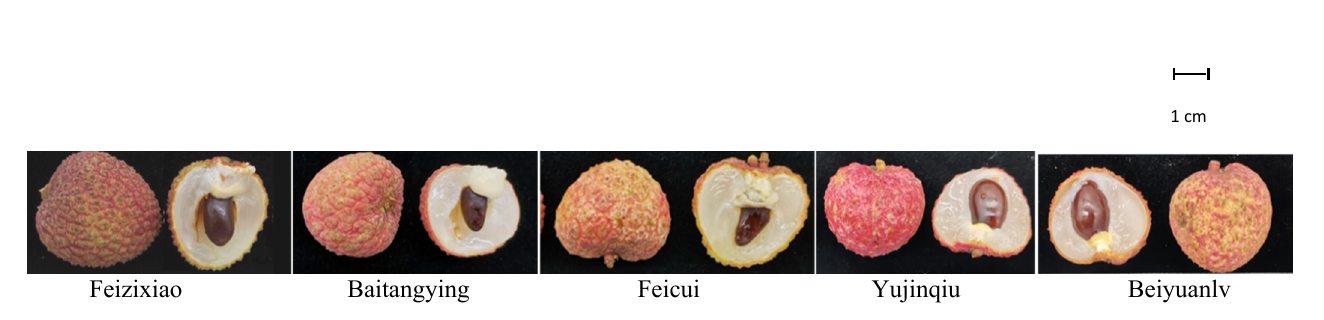
Figure 7. Image description of five Litchi cultivars. Table 2. Sample details of different litchi cultivars.